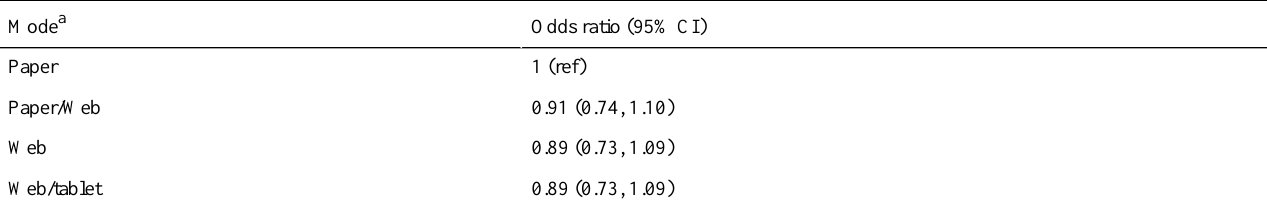
Table 2. The odds ratio of response rate by the 4 different modes in the Danish 2011 NordChild questionnaire